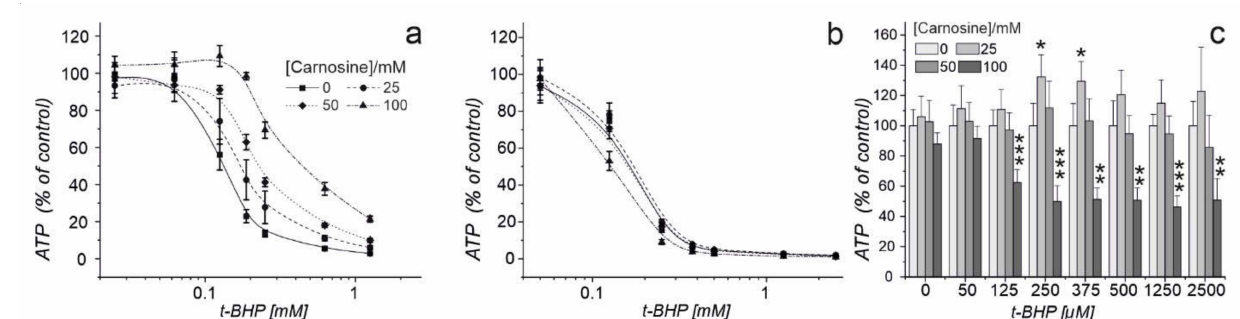
Figure 2. Response of erythrocytes towards oxidative stress when carnosine is present in the medium ( a ) or after pre- loading of cells with carnosine ( b , c ). ( a ): Erythrocytes from a healthy volunteer (male, age 29) were incubated for 1 h in medium containing different concentrations of t-BHP and 3 different concentrations of carnosine. ( b , c ): Cells from the same individual were preloaded with carnosine for 24 h, medium removed and fresh medium with different concentrations of tBHP was added for 1 h. After incubation, ATP in cell lysates was determined in both experiments. Here, for each concentration of carnosine employed cells not exposed to tBHP (set as 100%) were used for normalization (Note: control not seen because of the logarithmic presentation of the data). Points of different t-BHP concentrations are connected with a B-Spline ( a , b ). ( c ): Separate comparison of viability at different concentrations of tBHP in erythrocytes pretreated with different concentrations of carnosine from the experiment presented in ( b ). Here, for each concentration of tBHP employed, cells not pretreated with carnosine (set as 100%) were used for normalization (0 vs. 25, 50 or 100 mM, respectively, *: p < 0.05; **: p < 0.005; *** p <